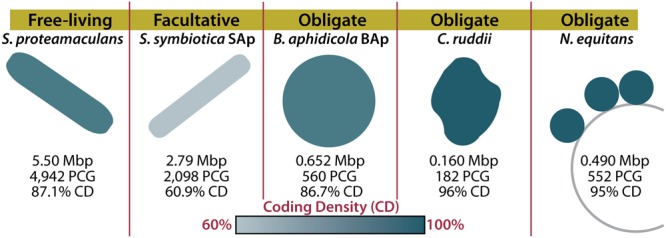
Host dependency and symbiont genome structure in reduced-genome organisms. Genome sizes and characteristics are shown for a free-living organism (Serratia proteamaculans), a facultative symbiont (Serratia symbiotica SAp), and three obligate symbionts (Buchnera aphidicola BAp, Carsonella ruddii, and Nanoarchaeum equitans). The color of the organism indicates the coding density of the genome. Mbp, mega base pairs; PCG, protein coding genes; CD, coding density (Waters et al., 2003; Nakabachi et al., 2006; Tamames et al., 2007; Lamelas et al., 2011).